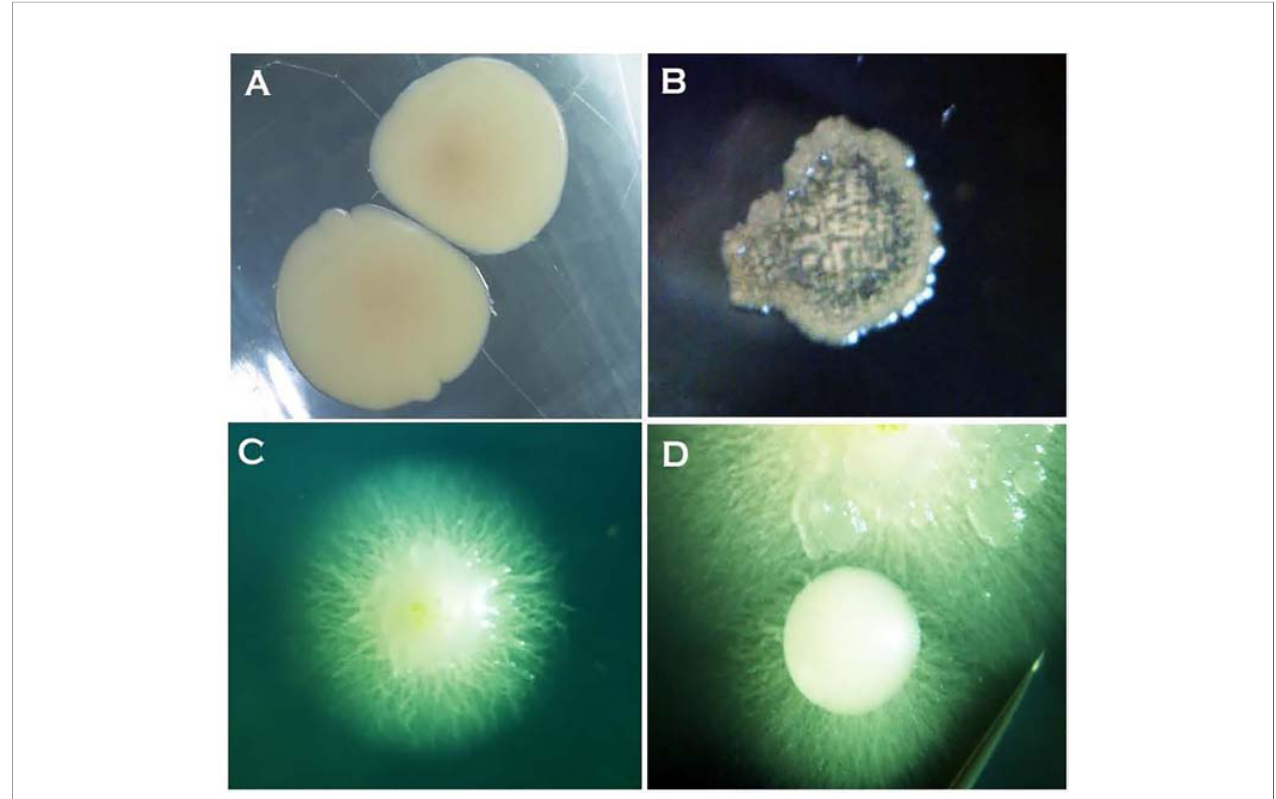
FIGURE 2 | Two-day-old bacteria-like colonies of Neopseudocercosporella capsellae consisting of single-celled blastopores appeared after streak-inoculation using hyphal fragments from a pure hyphal colony. (A) Isolate UWA Wlj-3 on NDY and (B) isolate UWA Wlra-7 on PDA. (C) and (D) Ten-day-old colonies of isolate UWA Wlj-3 on PDA where hyphae initiation is evident at the periphery at the transition stage from a bacterial-like initial stage.